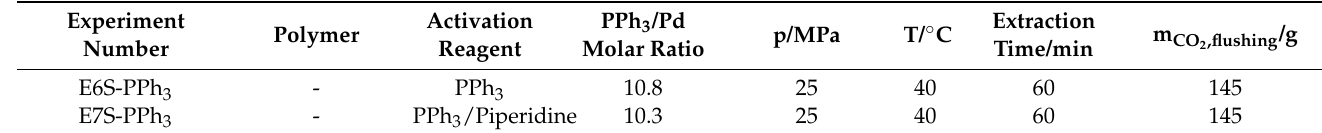
Table 2. Extraction parameters for PPh 3 extraction tests (ExS-PPh 3 : Screening experiments).